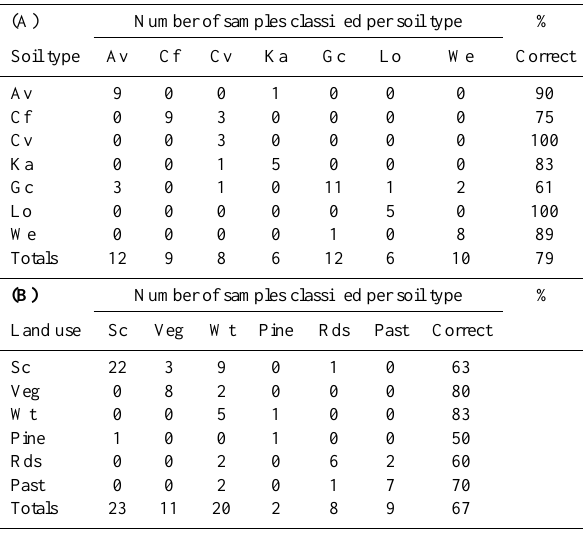
Table 4. Discriminate analysis classification matrix. (A) Soil type and (B) land